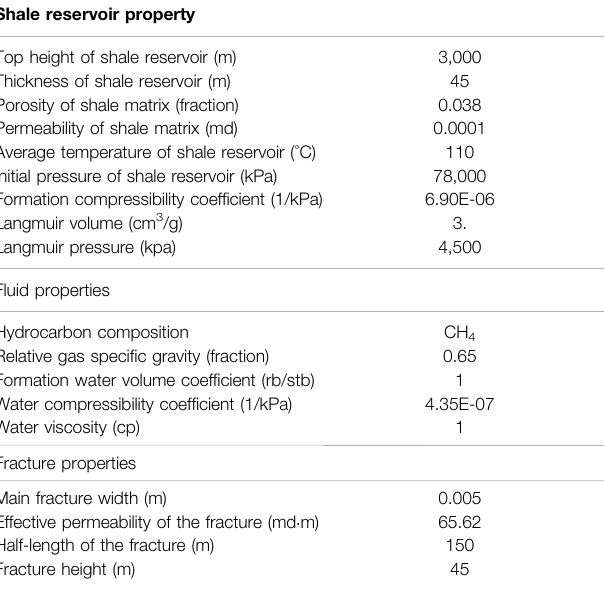
TABLE 1 | Full-scale simulation model description.